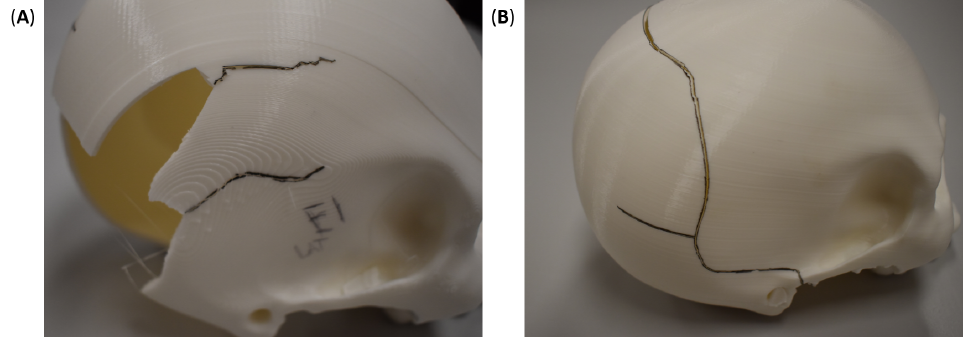
Figure 7. Fracture patterns (shown in black lines) in 3D-printed ( A ) sagittal-cut and ( B ) whole skulls after lateral compressive